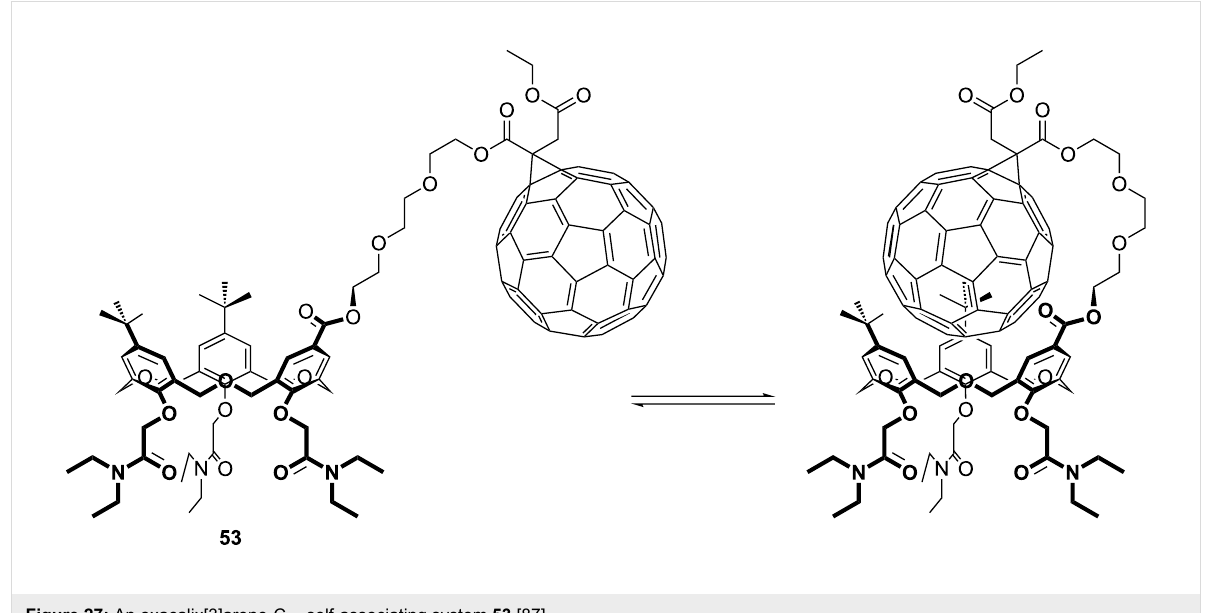
Figure 27: An oxacalix[3]arene-C 60 self-associating system 53 [87].